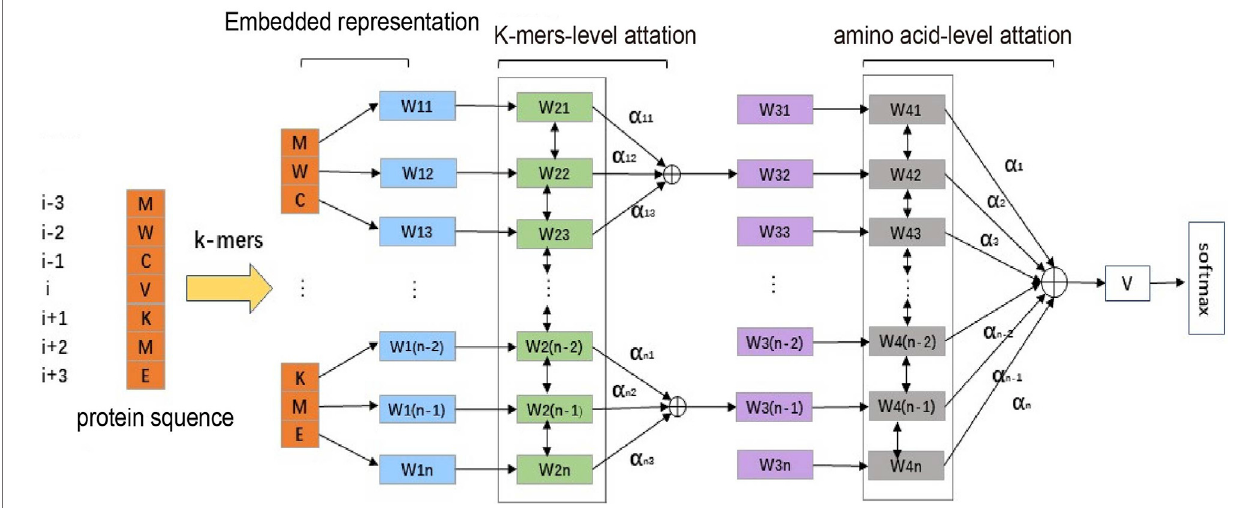
FIGURE1| StructureofHANPPIS.Itconsistsofthreesteps,includingembeddedrepresentation,aminoacid – levelattentionandK-mers – levelattention.Weobtain vectorrepresentationsofproteinsequencefragmentsthroughmultidimensionalfeatures.Thevectorrepresentationoftheproteinfragmentistheinputtothe fi rstlayerof the attention mechanism, and then the vector representation of the protein sequence is obtained through the second layer of attention and fi nally input to the prediction layer.